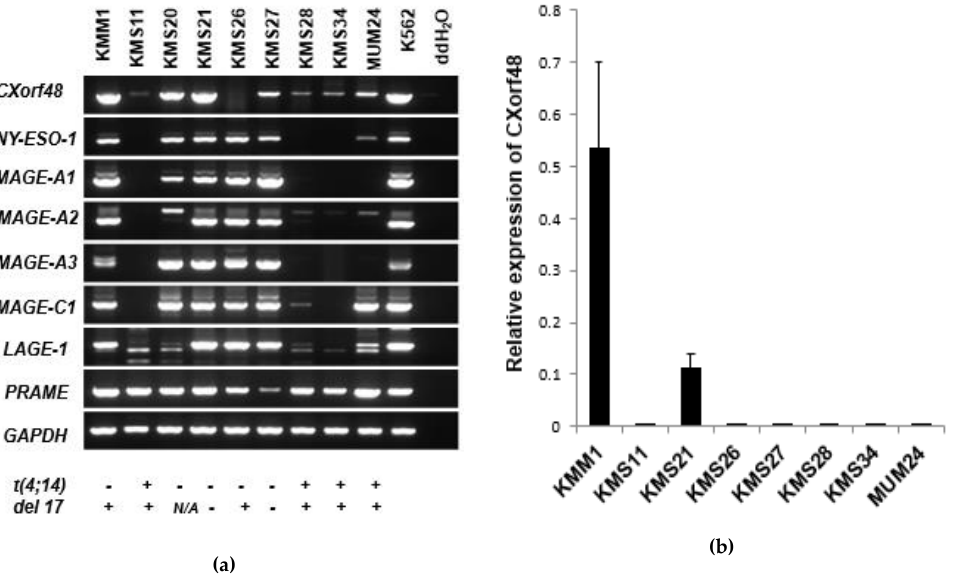
Figure 1. CXorf48 gene expression in multiple myeloma (MM) cell lines. ( a ) Expression of CXorf48 gene and other cancer-testis antigen (CTA) genes in nine myeloma cell lines were detected using conventional reverse transcription polymerase chain reaction (RT-PCR). K562 was used as a positive control. Chromosomal abnormalities were indicated below. N / A; not analyzed. ( b ) Expression of CXorf48 genes in myeloma cell lines was evaluated by quantitative PCR. Relative expression was calculated by dividing expression level of CXorf48 by that of GAPDH . K562 was used as a positive control to make standard curves. Data are mean with standard deviations.